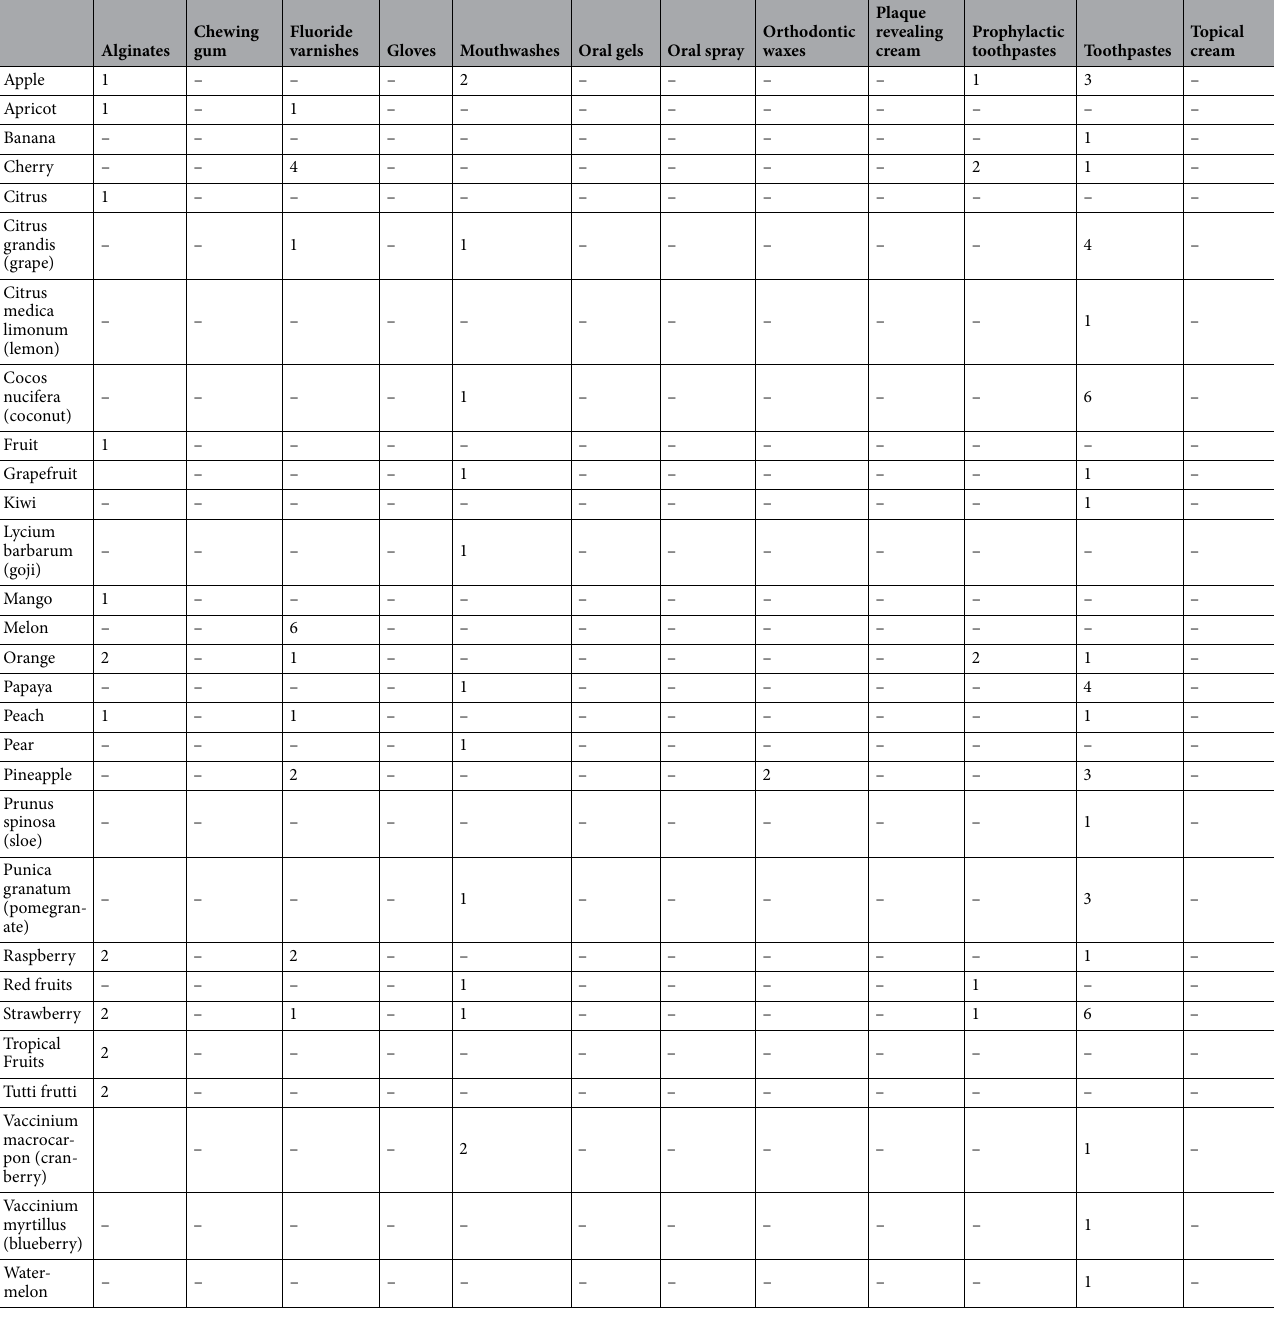
Table 4. Fruits in the studied OCP